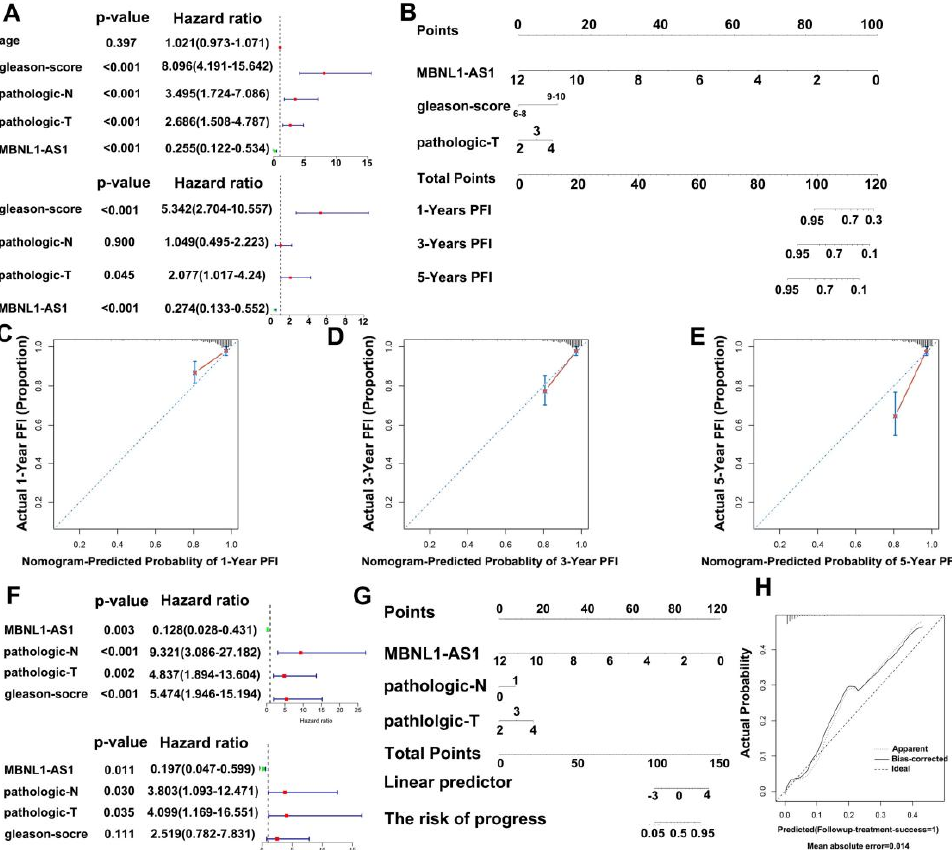
Figure 9. Construction of a nomogram to determine the clinical value of MBNL1-AS1 in predicting the prognosis and metastasis of PC. ( A ) Univariate and multivariate Cox regression analyses were performed to screen for variables significantly associated with PFI. ( B ) Nomogram to predict the probability of 1-, 3-, and 5-year PFI. ( C – E ) Calibration plots of the Nomogram were used to predict the probability of 1-, 3-, and 5-year PFI. ( F ) Univariate and multivariate Cox regression analyses were performed to screen for variables significantly associated with distant metastasis. ( G ) Nomogram to predict the probability of distant metastasis. ( H ) Calibration plots of the nomogram were used to predict the probability of distant metastasis.